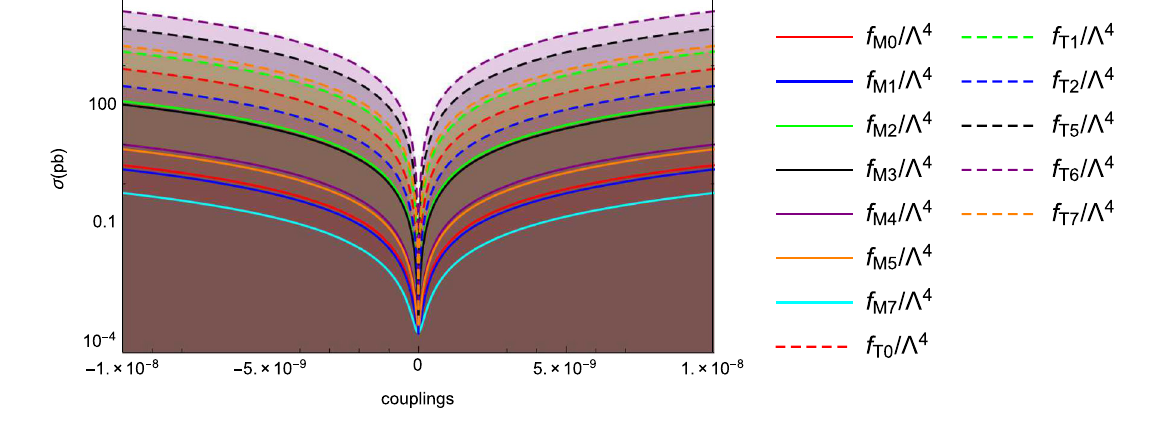
Fig. 8 Same as in Fig. 7, but for